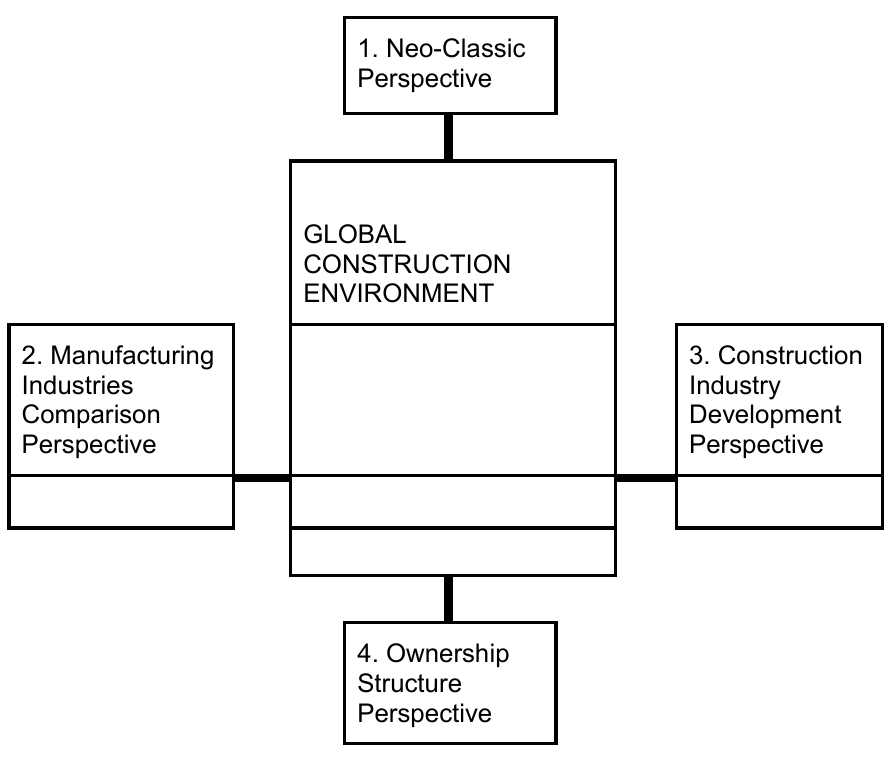
Fig. 1: A conceptual framework to initiate analysis of the ‘global construction environment’ in relation to four selected